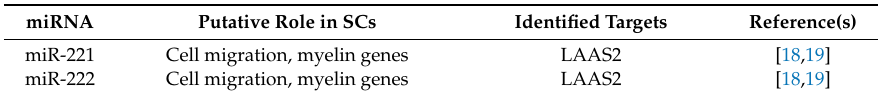
Table 2. Selection of miRNAs based on their involvement in regulating biological processes relevant to the Schwann cell “repair